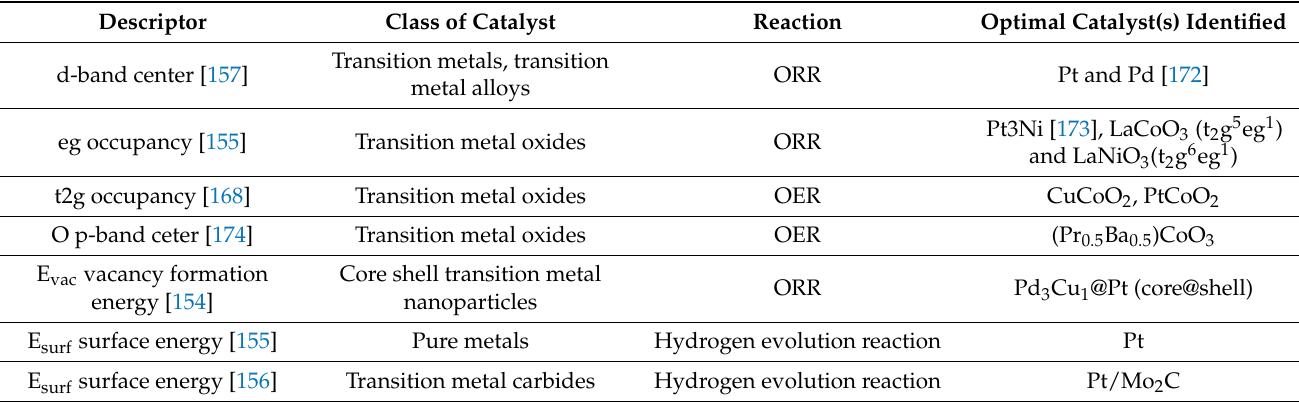
Table 1. A series of descriptors derive from different types of catalysts and reactions [150], Copyright 2017,